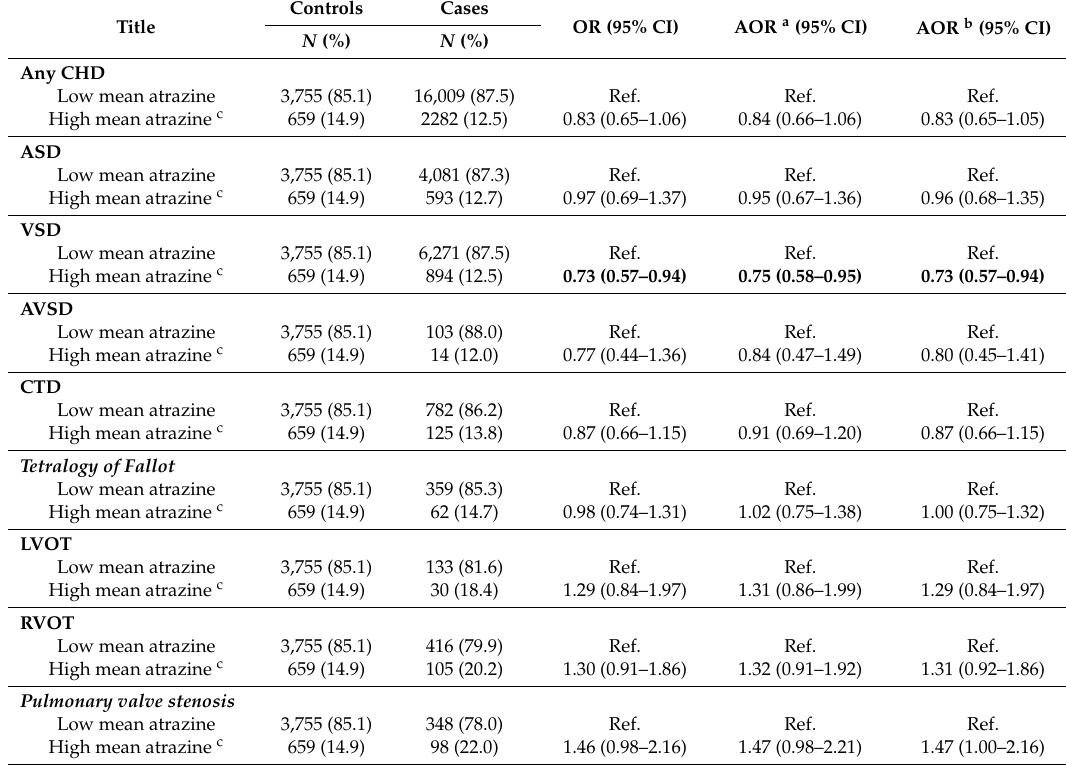
Table 3. Association between estimated high mean atrazine in drinking water and heart defects in offspring in Texas,